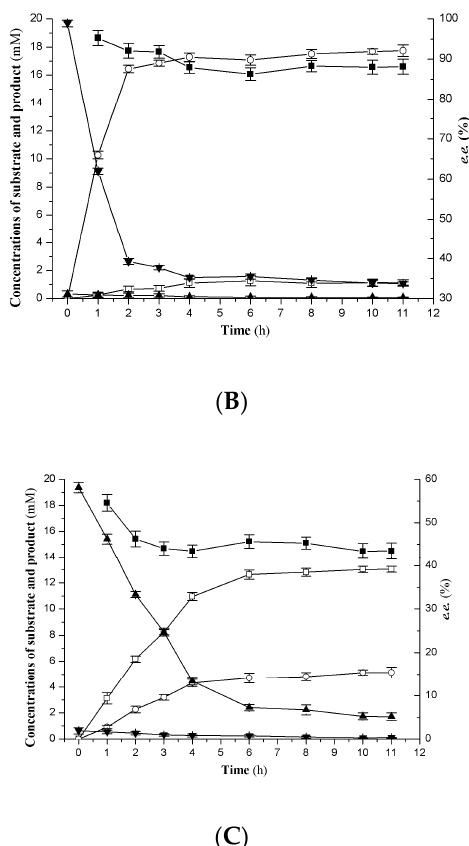
Figure 1. Asymmetric reduction of ( E / Z )-citral ( A ), ( E )-citral ( B ), and ( Z )-citral ( C ) using the purified OYE2y. □ , ( R )-citronellal; ○ , ( S )-citronellal; ▲ , geranial; ▼ , neral; ■ , the e.e. value of hydrogenated product. Data present mean values ± SD from three independent experiments.